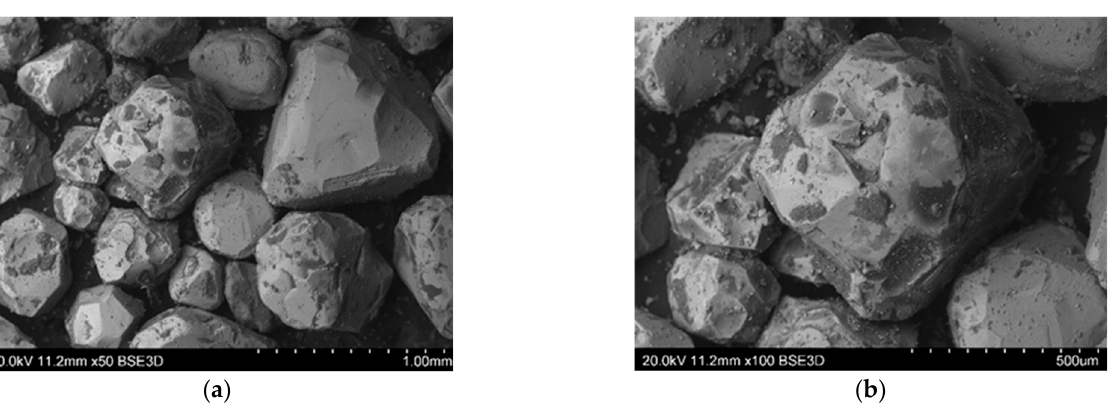
Figure 15. BSD images from the scanning electron microscope of the P100 chromite grain matrix: ( a ) mag. 50×, ( b ) mag. 100×.